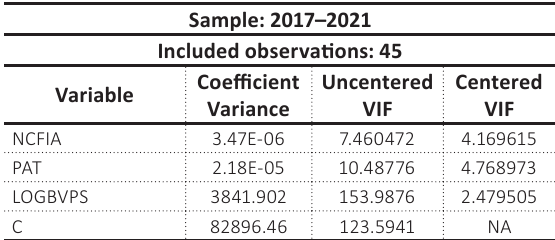
Table 3. Variance inflation